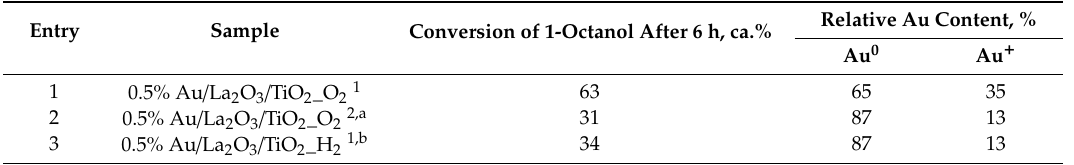
Table A1. Catalytic results of the most active catalyst in the aerobic oxidation of 1-octanol and contribution of various electronic states of gold in this catalyst, calculated by XPS. Adapted from [39] .